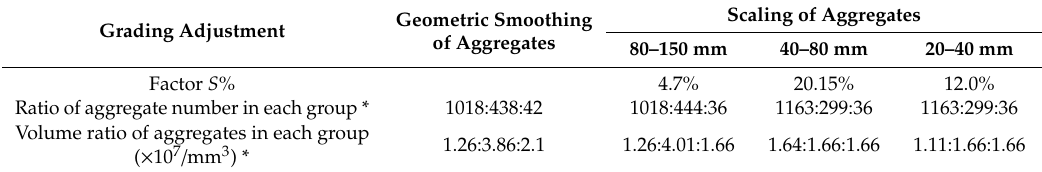
Table 2. Scaling factors and gradation changes during geometric smoothing and scaling